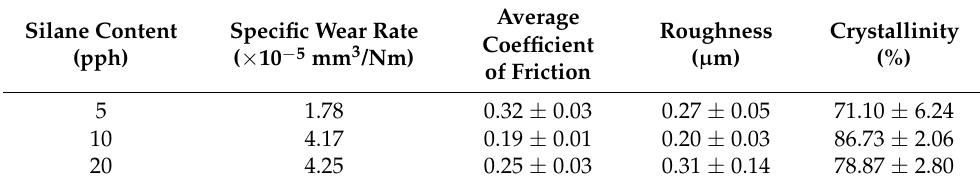
Table 9. Specific wear rate, average coefficient of friction, surface roughness, and crystallinity of treated Sm 2 O 3 /UHMWPE composites with varying silane contents of 5, 10, and 20 pph and Sm 2 O 3 content of 25